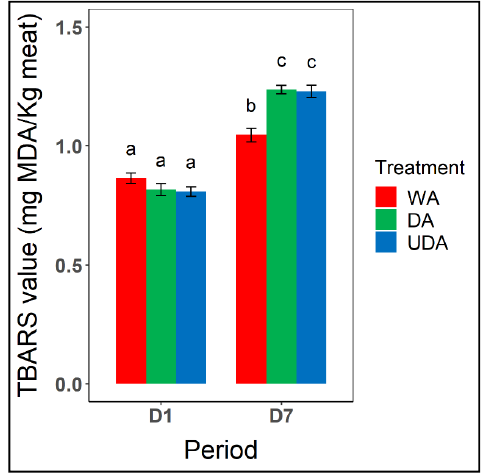
Figure 2. Effect of different aging treatments on lipid oxidation of pork loins ( M . Longissimus lumborum ) aged for 21 days. Different aging treatments: wet-aging (WA), conventional dry-aging (DA), and UV-light dry-aging (UDA). a–c Means with different letters indicates significant differences within the same display day ( p <